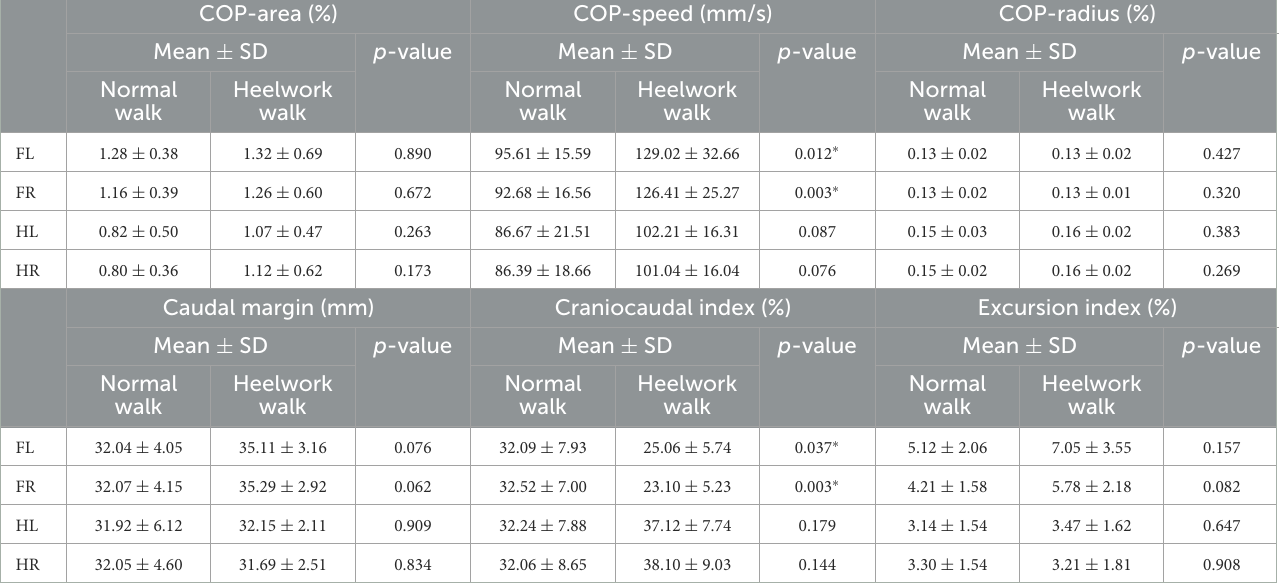
TABLE 7 Mean values, standard deviation, and significant differences between normal walking and heelwork walking of the center of pressure. COP-area (%) COP-speed (mm/s) COP-radius (%) Mean ± SD p -value Mean ± SD p -value Mean ± SD p -value Normal Heelwork Normal Heelwork Normal Heelwork walk walk walk walk walk